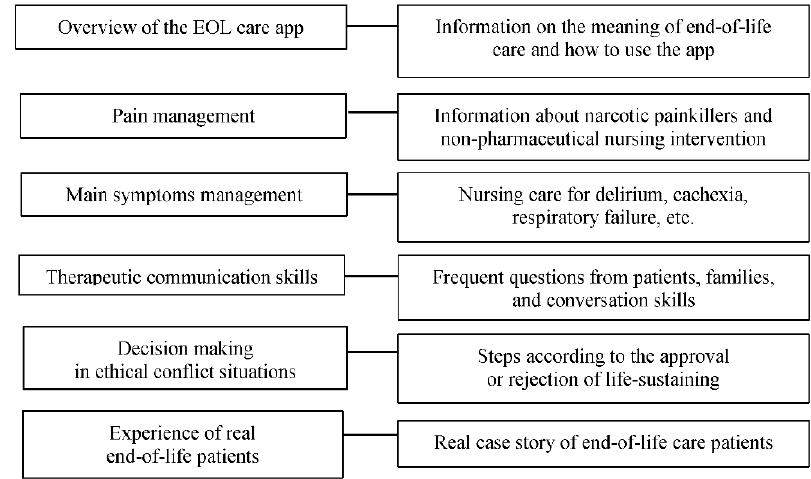
Figure 1. Contents of the end-of-life care application for intensive care unit nurses.